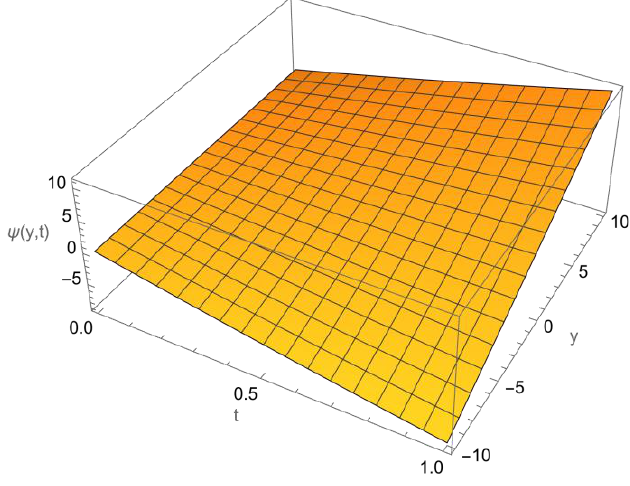
Figure 3. Exact solution ψ ( y , t ) of Example 3.